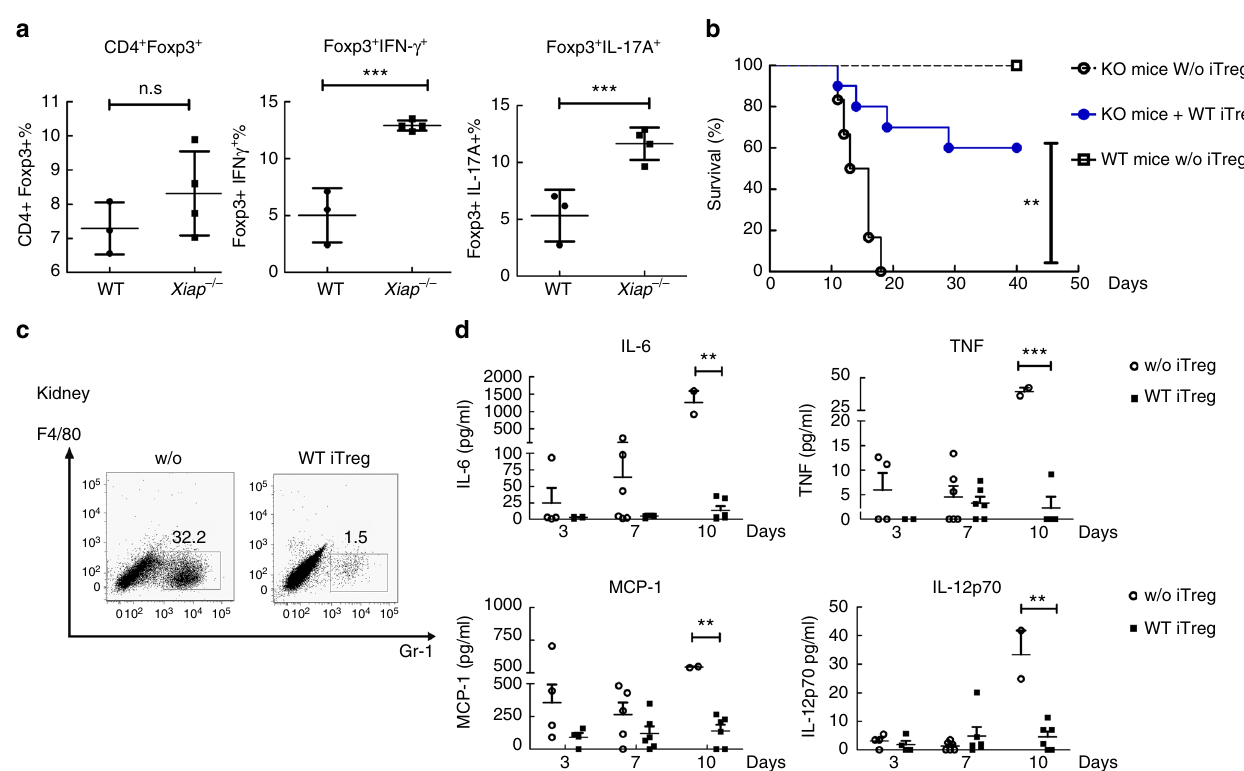
Fig. 6 Transfer of Treg cells rescues Xiap − / − mice from lethal Candida albicans infection. a Increased expression of IFN- γ + and IL-17 + cells in Xiap − / − Treg cells upon Candida albicans infection. WT and Xiap − / − female mice were intravenously infected with C. albicans (1 × 10 5 ), and mice were killed at day 10. T cells were isolated from spleen, and the frequencies of CD4 + Foxp3 + , Foxp3 + IFN- γ + and Foxp3 + IL-17 + cells were quantitated by intracellular staining. b Transfer of WT iTreg cells partially rescues Xiap − / − mice from C. albicans -induced lethality. WT and Xiap − / − female mice were intravenously administered with C. albicans (1 × 10 5 ) and a group of Xiap − / − mice also received WT iTreg cells (1 × 10 6 ) at day 2. Survival of mice was monitored and is presented as a Kaplan – Meier survival curve ( n = 7 for each group). ** P < 0.01. c Reduced kidney in fl ammation in C. albicans -infected Xiap − / − mice with WT iTreg cells transfer. Kidney was isolated from Xiap − / − mice 10 days after C. albicans injection and in fi ltrated neutrophil contents were determined. d Reduced in fl ammatory cytokine production in C. albicans -infected Xiap − / − mice into which WT iTreg cells had been transferred. Serum from mice was collected at the indicated time-points after C. albicans injection, and the levels of IL-6, TNF, MCP-1, and IL-12 were determined, n = 6. Values ( a , d ) are mean ± SD